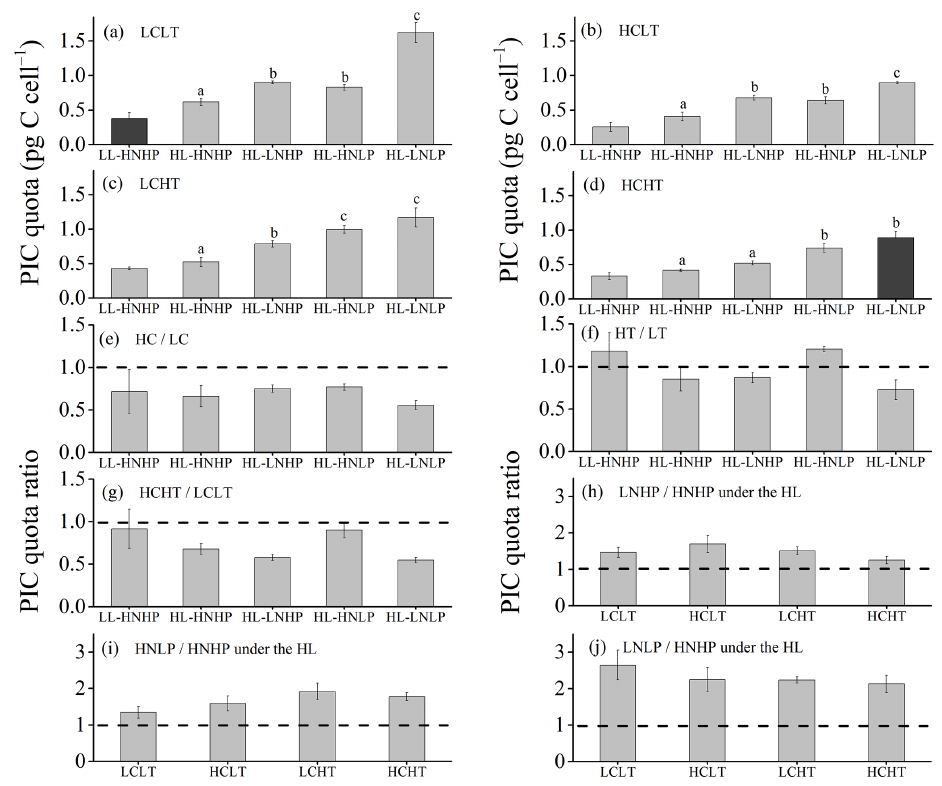
Figure 5. PIC quota of E. huxleyi grown in LCLT (a) , HCLT (b) , LCHT (c) and HCHT (d) conditions and the ratio of the PIC quota in HC to LC (e) , HT to LT (f) , HCHT to LCLT (g) , LNHP to HNHP (h) , HNLP to HNHP (i) and LNLP to HNHP (j) conditions. Data were obtained after cells were acclimated to experimental conditions for 14–16 generations and means ± SD of four replicate populations. Horizontal lines in (e) – (j) show the value of 1. Different letters (a, b, c) in (a) – (d) represent significant differences between different nutrient treatments (Tukey post hoc, p < 0.05). The results shown in the black columns were used for the ambient-future comparison in Fig. 2. Detailed experimental conditions are shown in Fig.